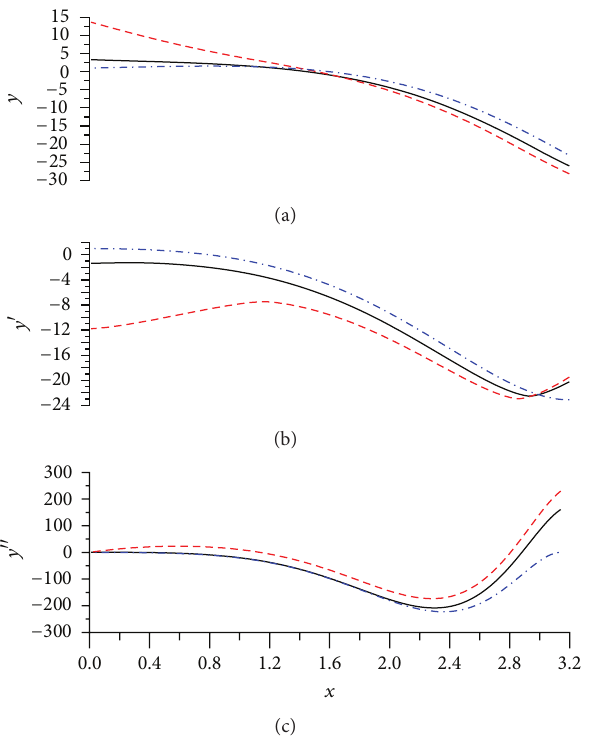
Figure 8: A nonlinear perturbation of Example 4, displaying two solutions of (a) 𝑦 , (b) 𝑦 󸀠 , and (c) 𝑦 󸀠󸀠 .